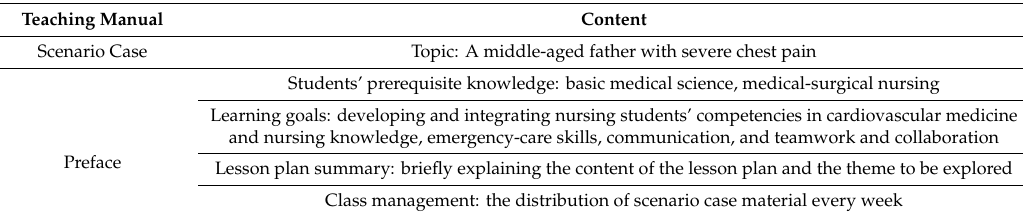
Table 3. Example from the teaching manual: a scenario involving a patient with acute coronary vascular